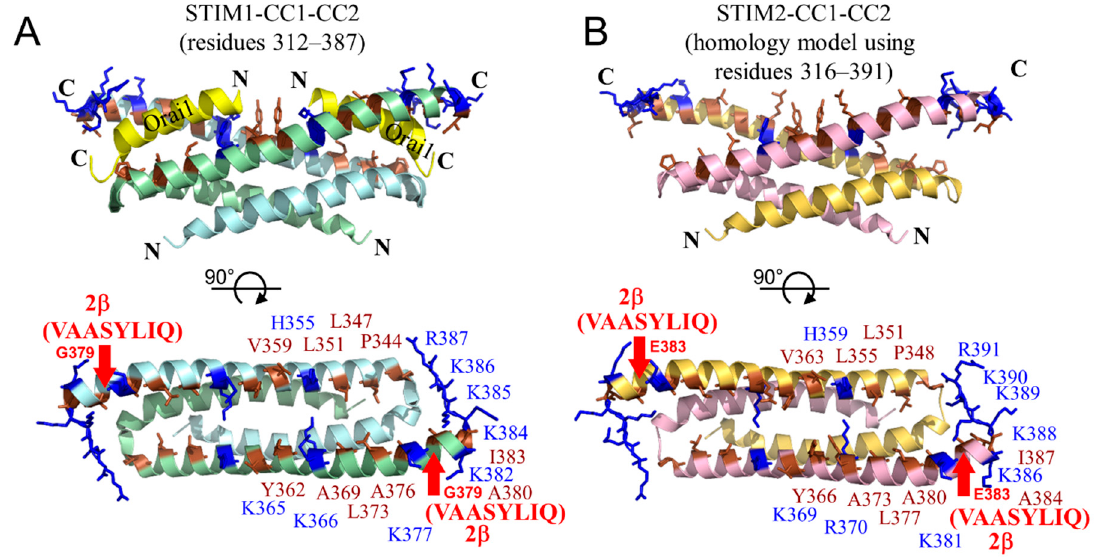
Figure 8. STIM CC1-CC2 structures identifying the location of the 2 β variations. ( A ) Cartoon view of the backbone atoms making up the CC1 and CC2 helices in the dimeric human STIM1 CC1-CC2 solution structure. The location of the two human Orai1 C-terminal helices (yellow ribbons) are indicated (top view). The hydrophobic (brown sticks) and positively charged (blue sticks) residues within the CC2 helices making up the Orai1 C-terminal helix binding pocket are indicated and labeled (bottom view). ( B ) Cartoon view of the backbone atoms making the CC1 and CC2 helices in the dimeric human STIM2 homology model. The hydrophobic and positively charged residues making up the putative Orai1 C-terminal helix binding sites are indicated at top and bottom views. In ( A , B ), the relative locations of the 2 β variations within CC2 are shown (red arrows). The STIM2 homology model was created from the STIM1 CC1-CC2 solution structural coordinates (2MAK.pdb) in Modeller [54]. Structure images were rendered using PyMOL.